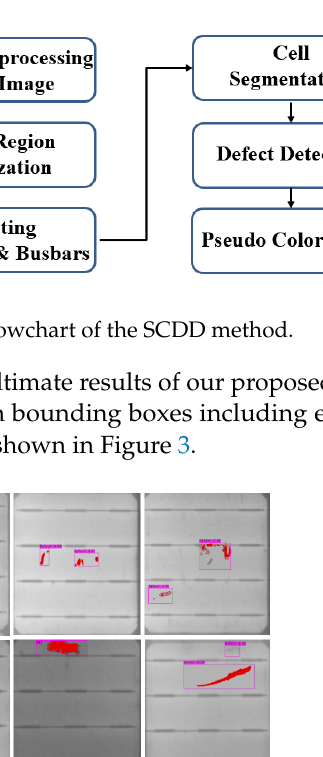
Figure 3. Results of the SCDD